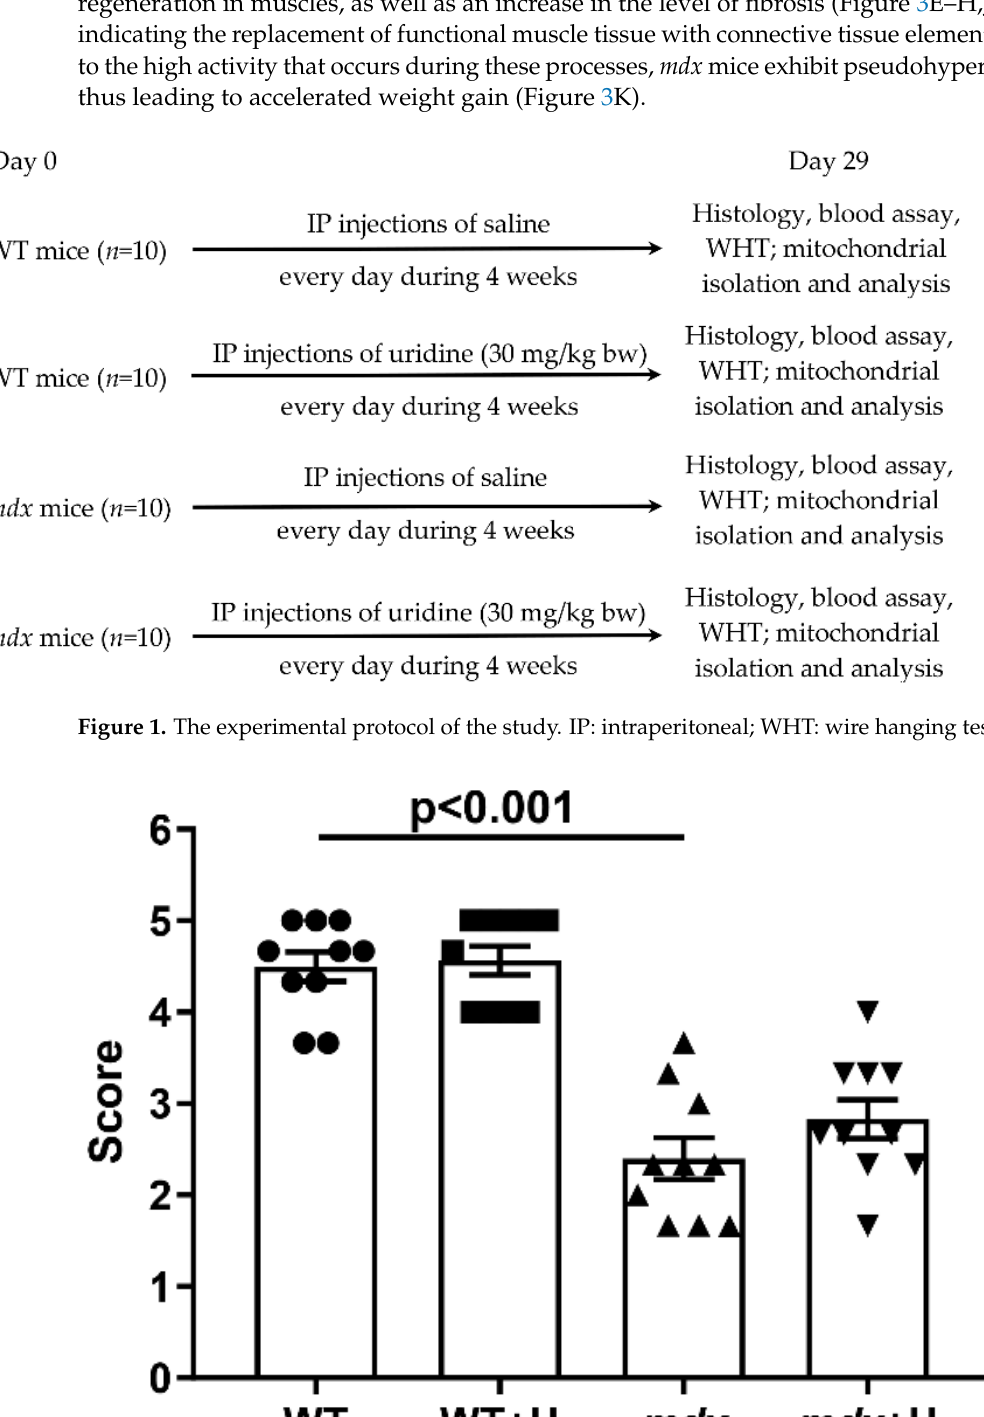
Figure 2. The results of a wire hanging test, reflecting the effect of uridine administration on muscle function and endurance in the studied groups of mice. The data are presented as means ± SEM ( n = 10).